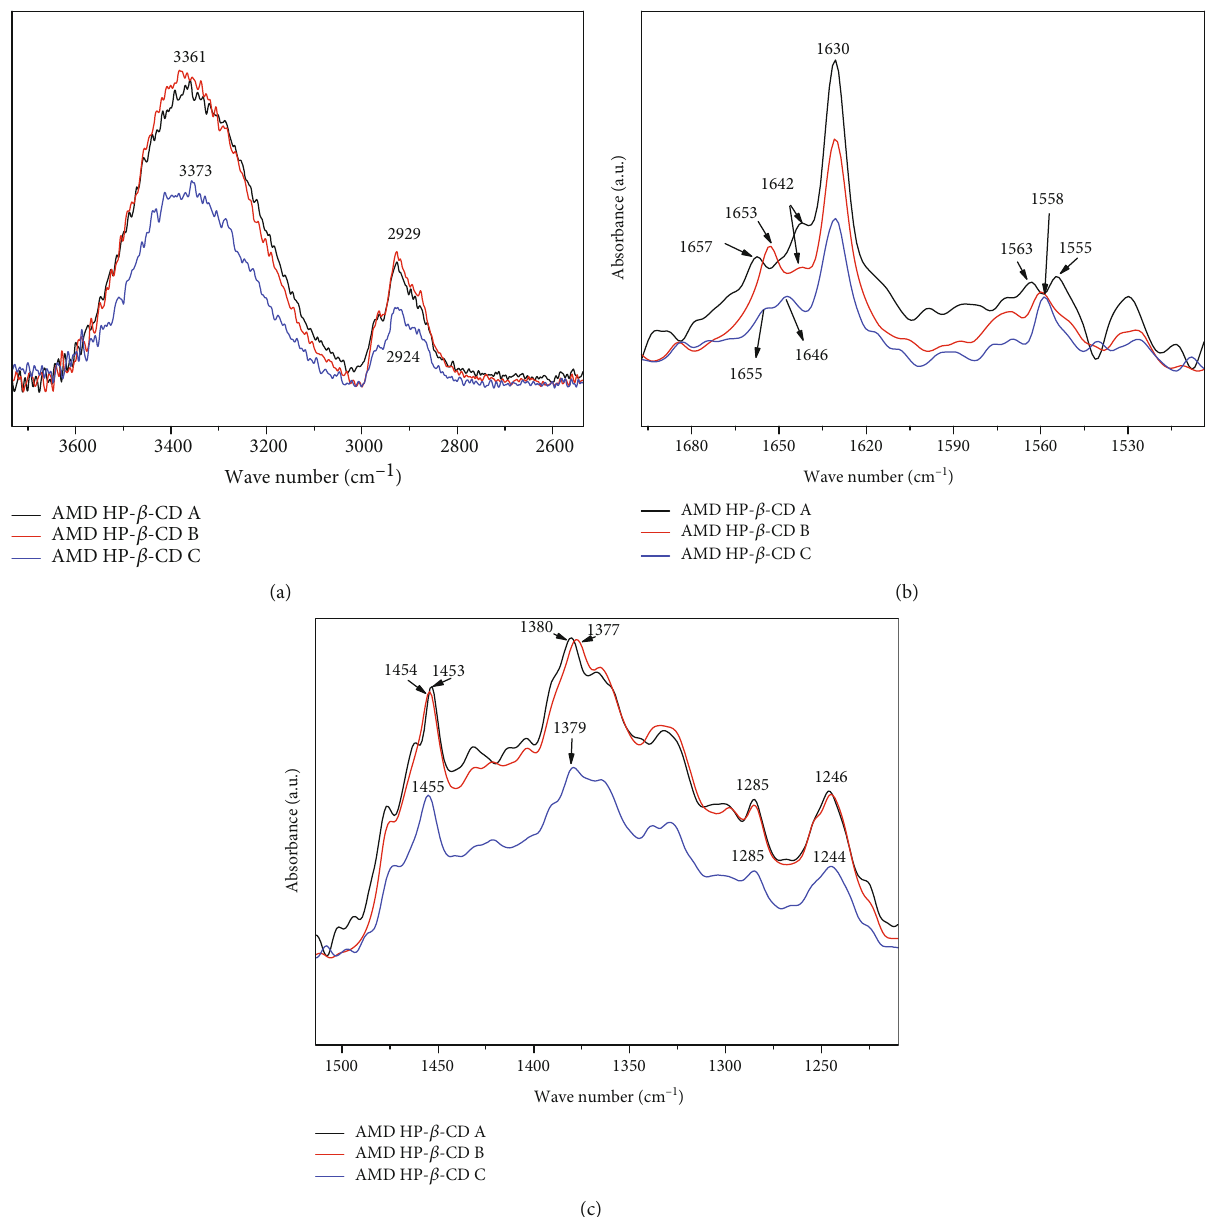
Figure 6: ATR-FTIR spectra of the three inclusion complexes in di ff erent spectral regions: (a) 2600-3600 cm -1 , (b) 1530 – 1680cm -1 , and (c) 1200 – 1500cm -1